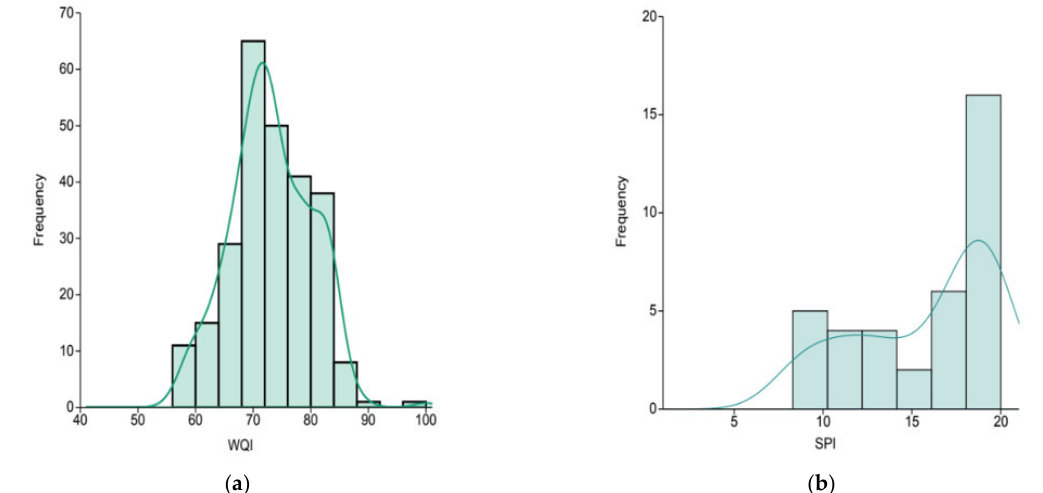
Figure 2. Histogram of WQI ( a ) and SPI ( b ) values obtained. Data fitted to a kernel density estimator.